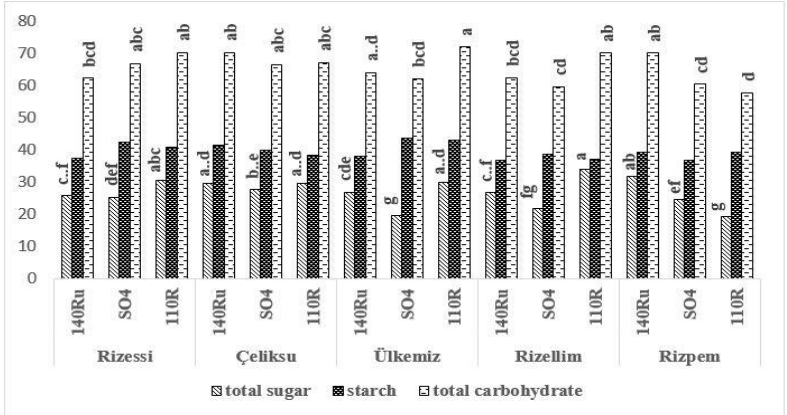
Figure 5. Above the graft area (scion) carbohydrate accumulations in grafted vine saplings. total sugar p < 0.01 LSD: 4.95, total carbohydrates p < 0.05 LSD: 8.31. a – g: differences between results shown with different letters in the same designs are statistically significant.